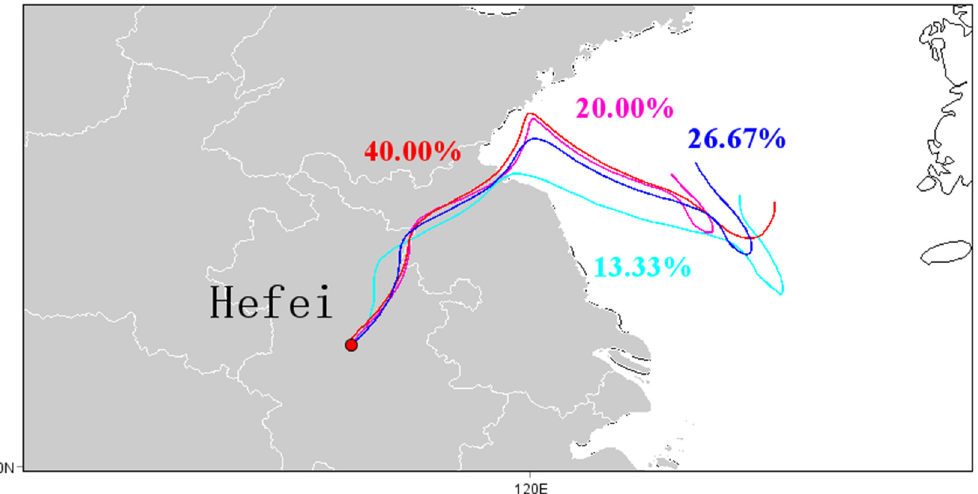
Figure 6. HYSPLIT backward trajectories during fog period in Hefei at 500 m height above ground level.